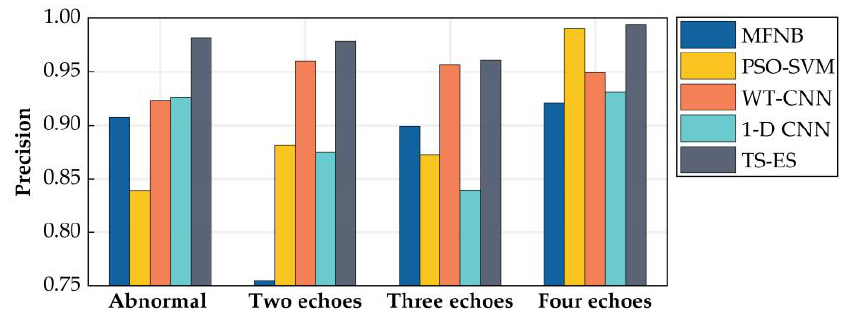
Figure 9. Precision of each method.